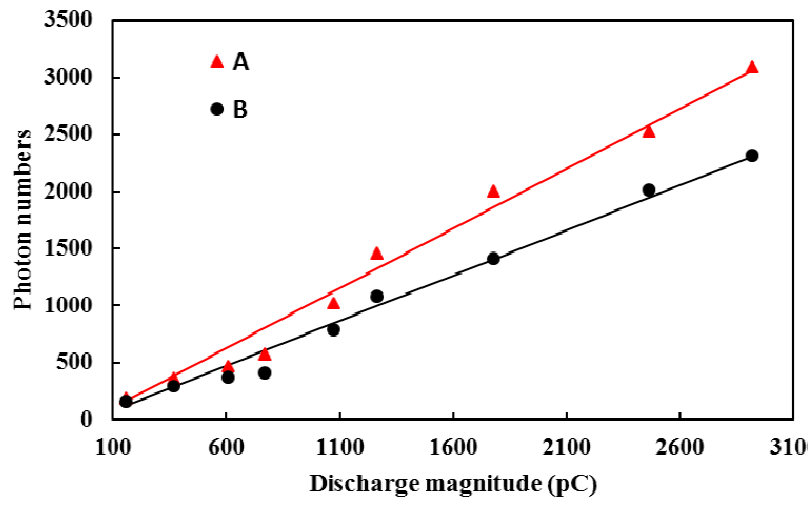
Figure 7. Relationship between photon number and discharge magnitude.